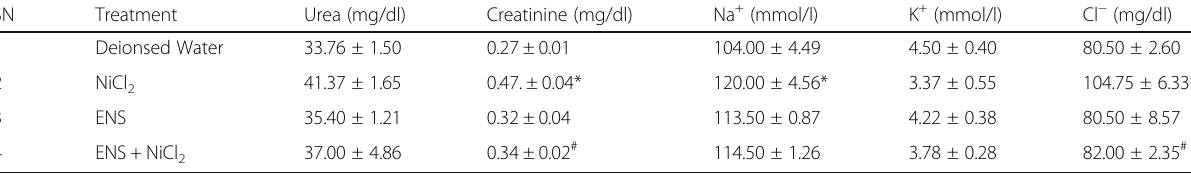
Table 3 Kidney function markers and electrolyte in the serum of test and control animals